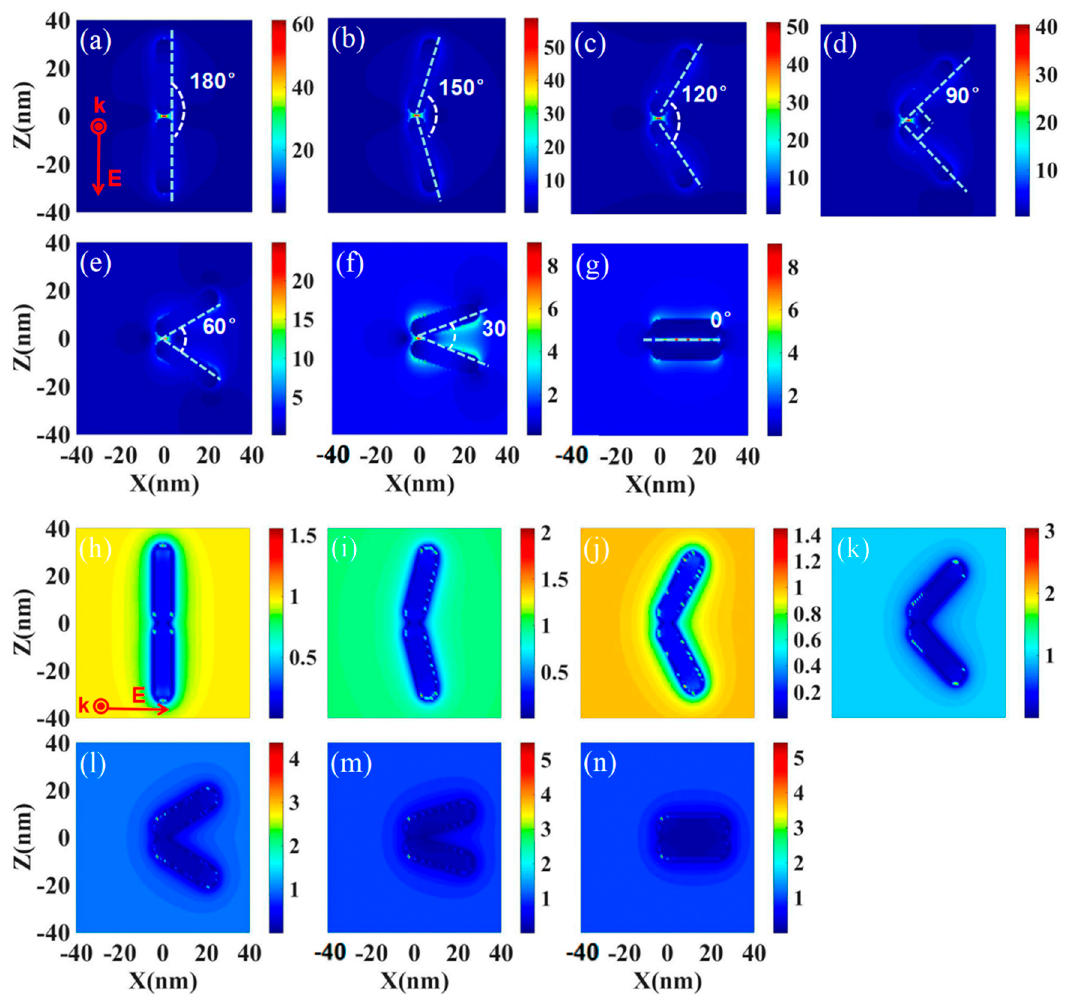
Figure 3. The near-field intensity map of two gold nanorods systems (LSPR 800 nm) at 800 nm laser excitation; the interparticle separation is 1 nm and the angle between the two nanorods varies from 0 degrees to 180 degrees. Both z and x polarization are studied. Images ( a )–( g ) show the z polarization; images ( h )–( n ) show the x polarization.